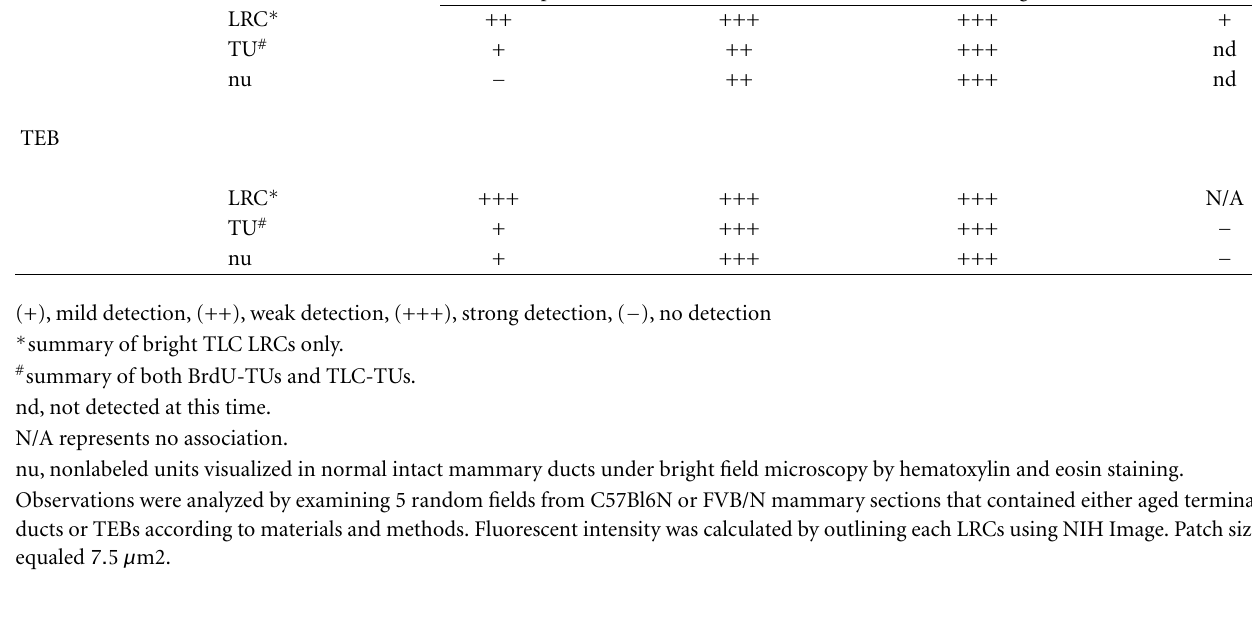
Table 2: Location of LRCs and TUs in various ductal compartments. Ducts End bud tip Duct Subtending